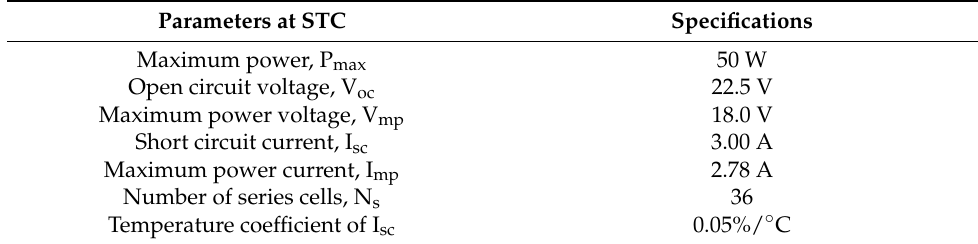
Table 2. PV module, PMS50W.